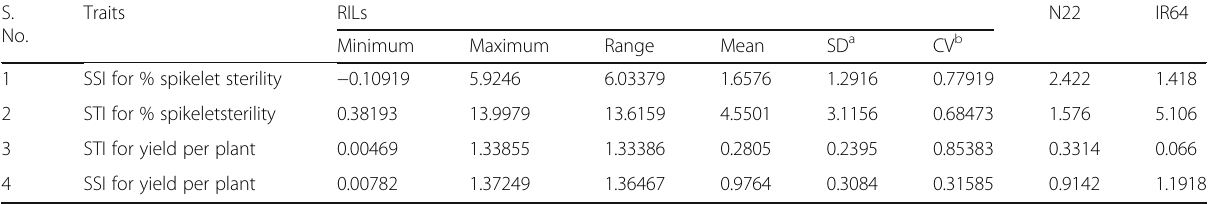
Table 2 Phenotypic variation for heat stress tolerance indices in Nagina22/IR 64 RIL mapping population S. No.